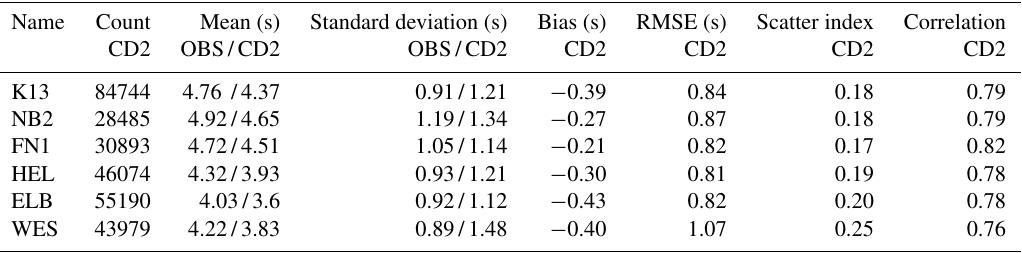
Table 3. Error metrics for the T m02 period at six locations derived from in situ observations (OBS) and coastDat2 hindcast (CD2) data for hourly